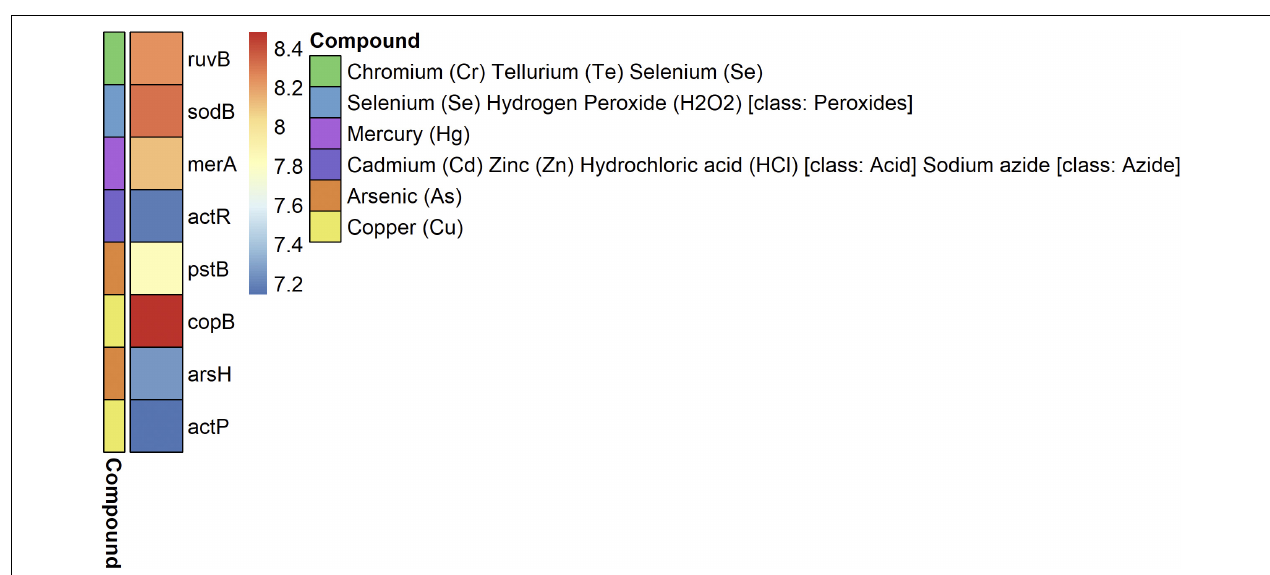
FIGURE 6 | Metal-resistance genes in the plasmidome of Puquio de Campo Naranja. The color scale indicates the abundance of each gene in FPKM (fragments per kilobase per million). Values are plotted on a logarithmic scale. The other colors indicate the metal to which they confer resistance.